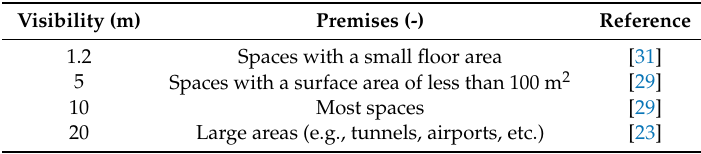
Table 1. Minimum visibilities recommended for di ff erent